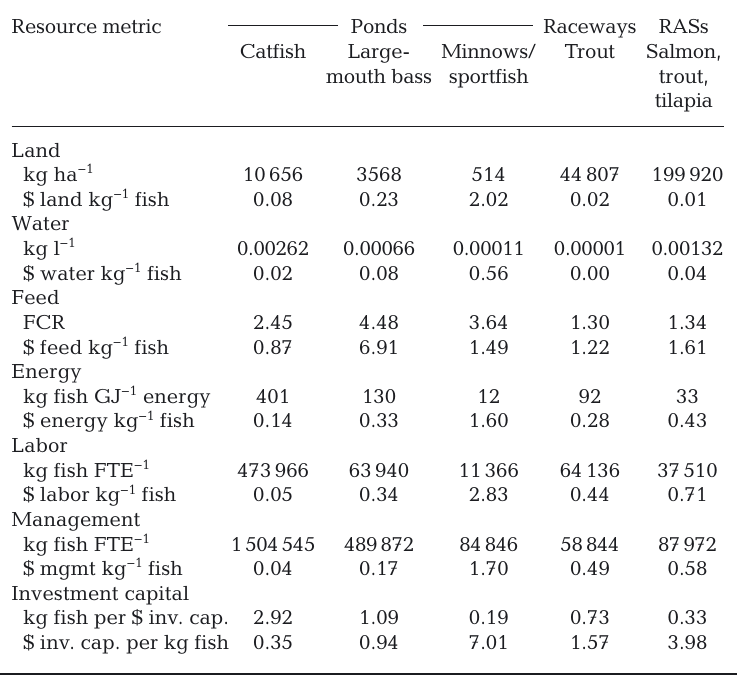
Table 3. Comparison of resource use and resource cost efficiencies by produc- tion system. RAS: recirculating aquaculture system; FCR: feed conversion ratio; FTE: full-time